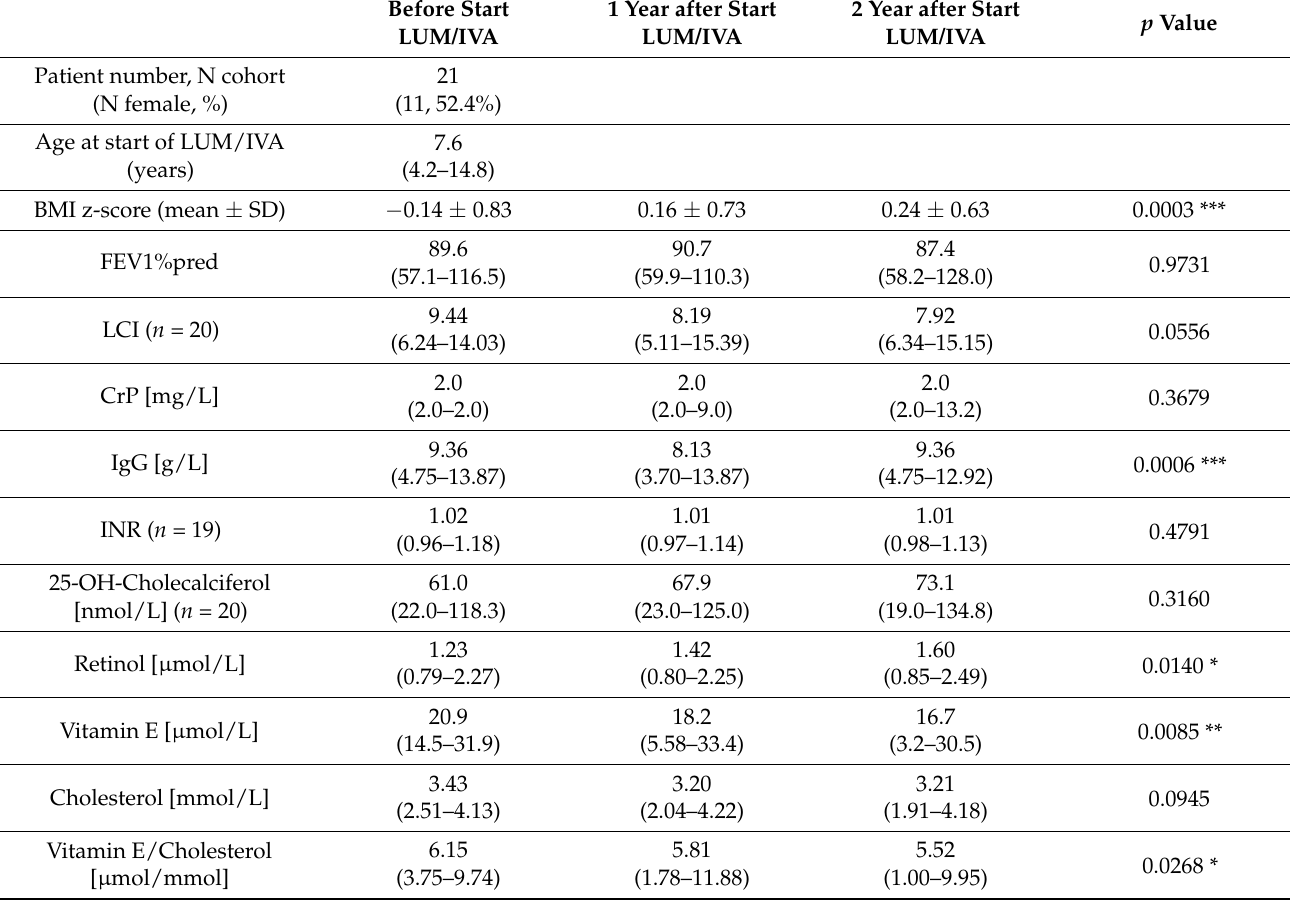
Table 3. Course of clinical parameters related to fat-soluble vitamins after two years of therapy with lumacaftor/ivacaftor (LUM/IVA) in a cohort of 21 patients with